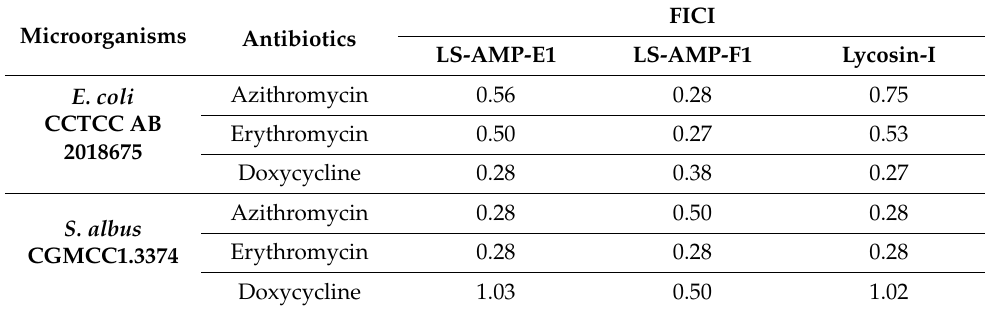
Table 1. FIC index of the standard strains.